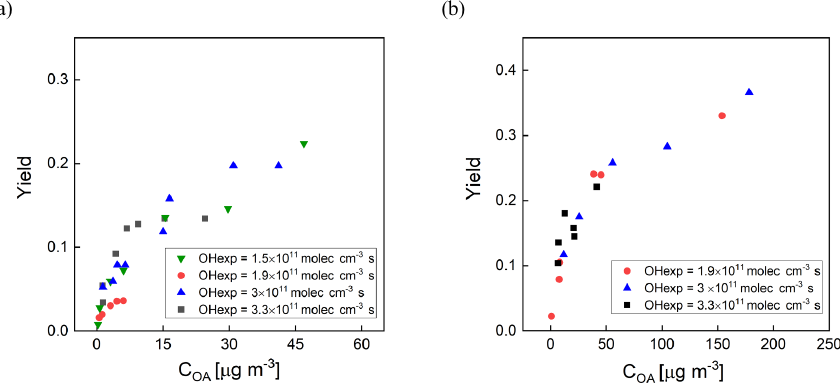
Figure 8. SOA yield as a function of organic aerosol concentration ( C OA ) for (a) m -xylene SOA and (b) α -pinene SOA generated in the PFA OFR. Marker color reflects experimental combinations of UV intensity, O 3 mixing ratio, and RH. Each marker represents one VOC